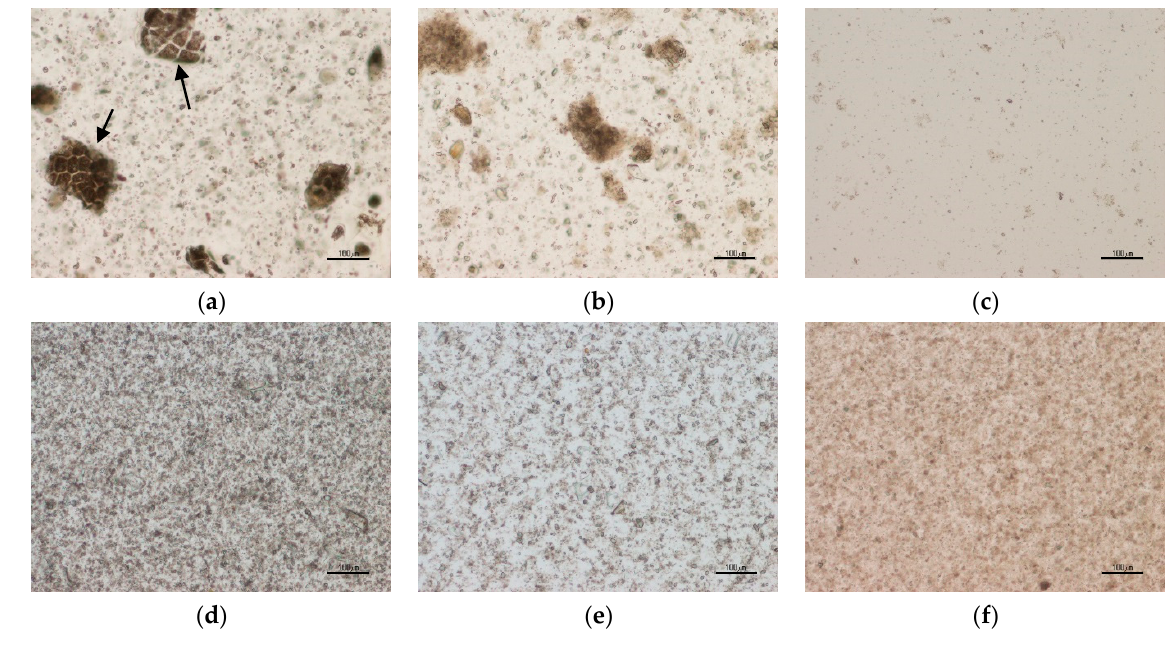
Figure 3. Microscopy of OBC samples in suspension: OBC ( a ), OBC-Hyd ( b ), OBC-Sol ( c ), OBC-M ( d ), OBC-Hyd-M ( e ), OBC-Sol-M ( f ). OBC: Oat bran concentrate; OBC-Hyd: OBC hydrolyzed with β -glucanase; OBC-Sol: water-soluble fraction from OBC after hydrolysis with β -glucanase; OBC-M: OBC microfluidized; OBC-Hyd-M: OBC-Hyd microfluidized; OBC-Sol-M: OBC-Sol microfluidized. The WRC of OBC and OBC-Hyd were at similar levels (3.0–3.1 mL/g), and microflu-